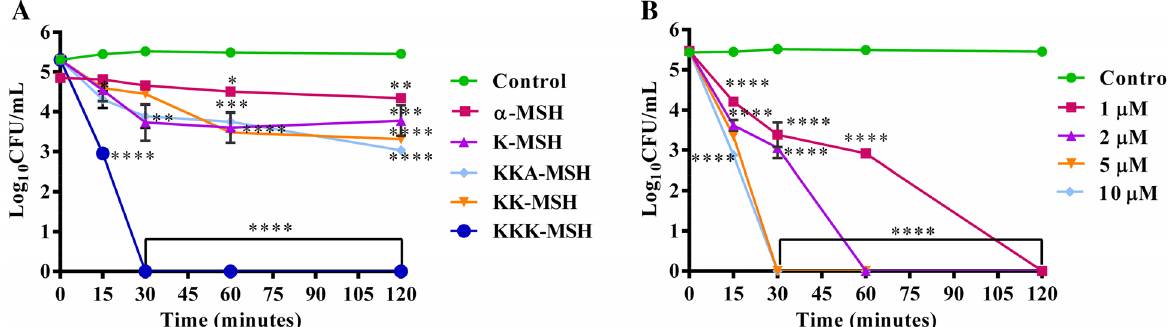
Figure 3. Effect of the stationary phase of E. coli cells on the killing kinetics of ( A ) α-MSH and its analogues at 10 µM concentration and ( B ) KKK-MSH at various concentrations. Experiment was repeated on three independent days, and the data was presented as mean ± SE. (**** P < 0.0001, compared to untreated